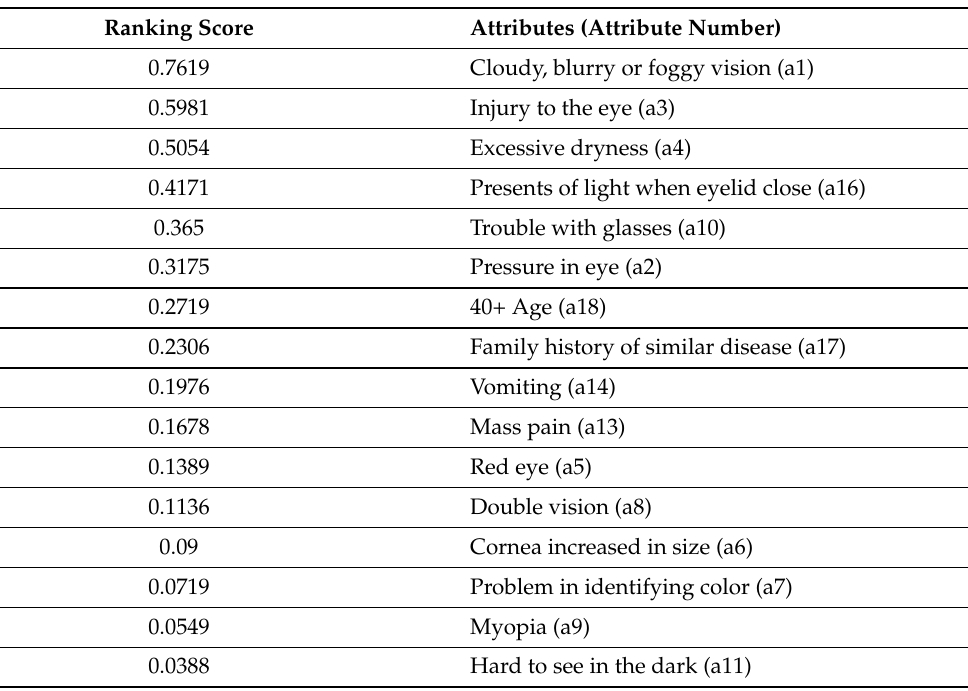
Table 6. Ranking of Features from PCA-based FS method.